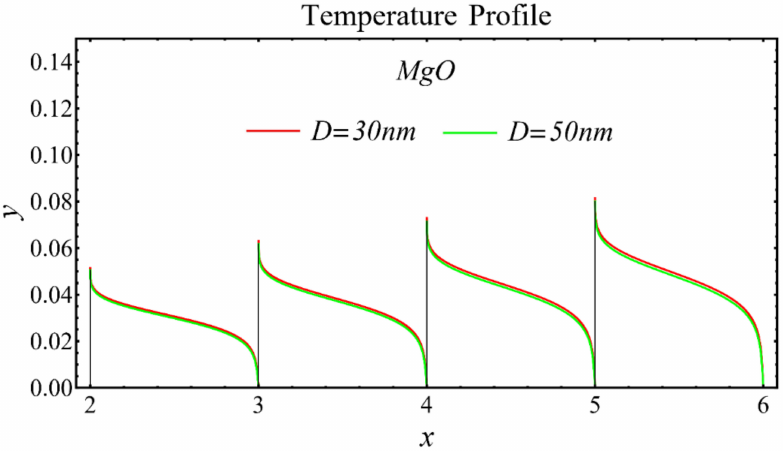
Figure 17. Temperature profile of MgO-EG nanofluid under influence of nanoparticle diameter.